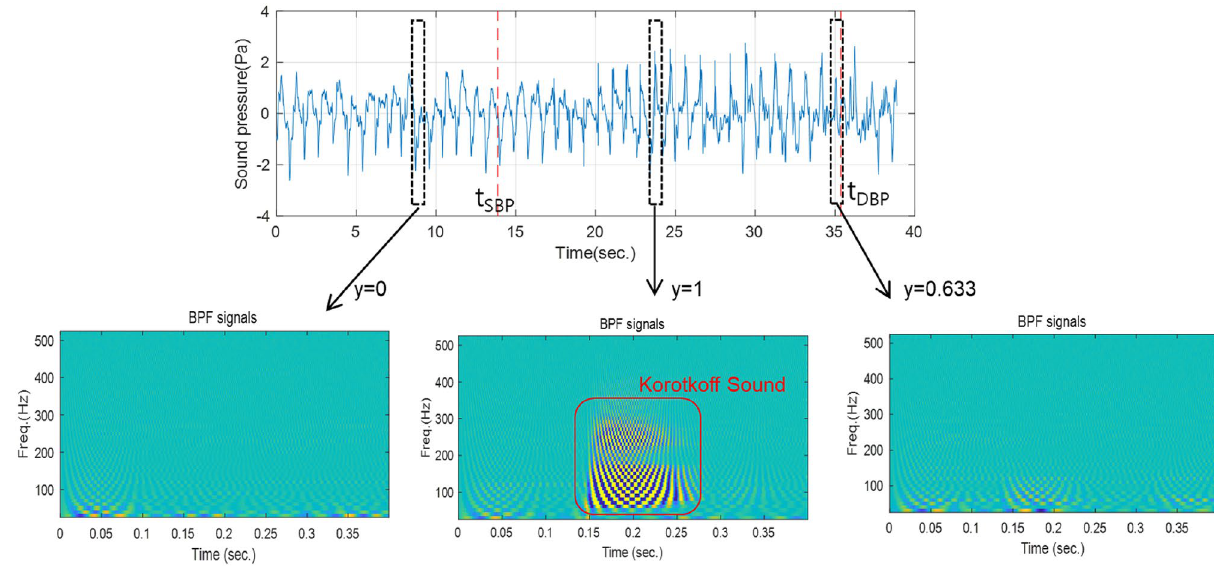
Figure 5. Examples of band-pass-filtered signal stacks and